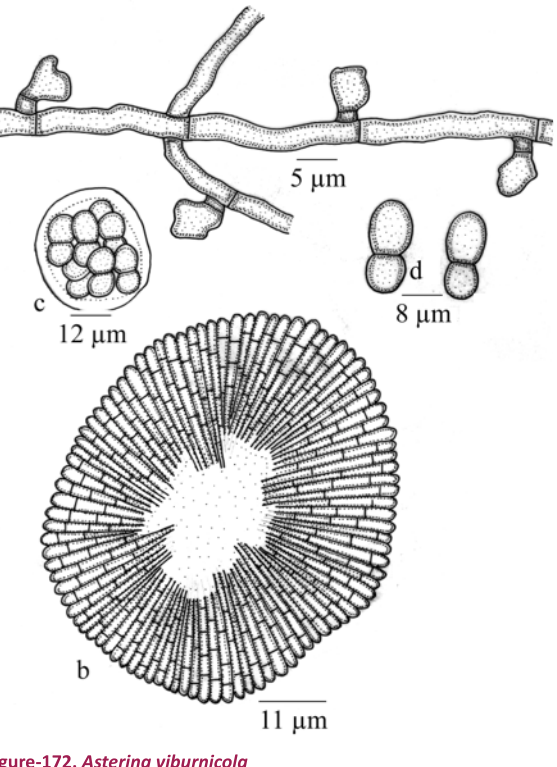
Figure-172. Asterina viburnicola a - Appressorium; b - Thyriothecium; c - Ascus; d -